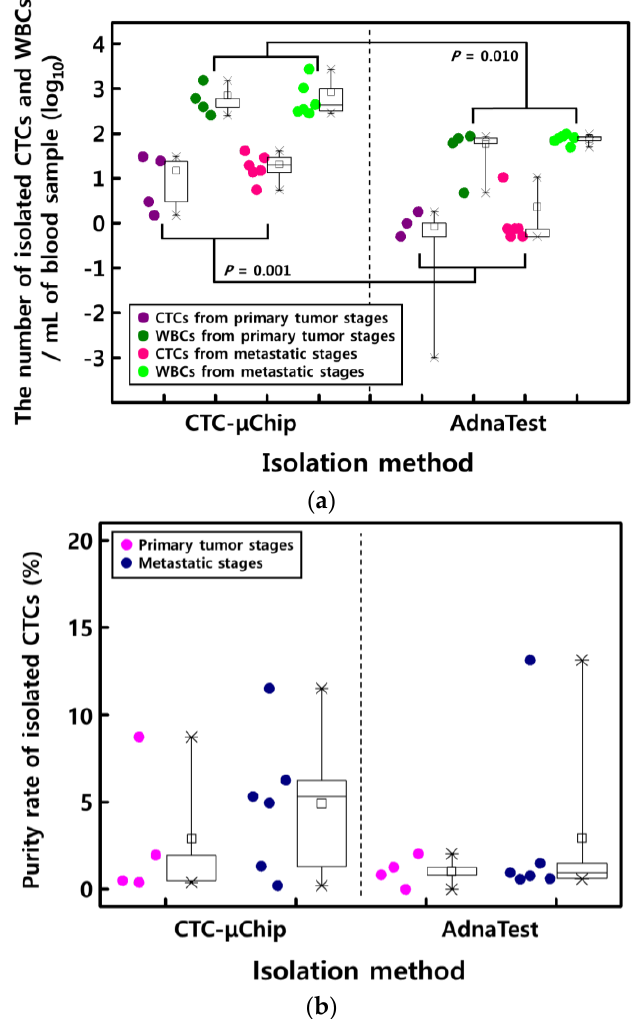
Figure 4. ( a ) The number of isolated CTCs and WBCs per milliliter of blood, with the CTC-µChip and AdnaTest. ( b ) The purity of CTCs in patients with primary and metastatic prostate cancer. CTC purity (%) = The number of isolated cytokeratin-positive cells (CTCs) × 100. (1) Total number of cytokeratin-positive cells (CTCs) and CD45-positive cells (WBCs)